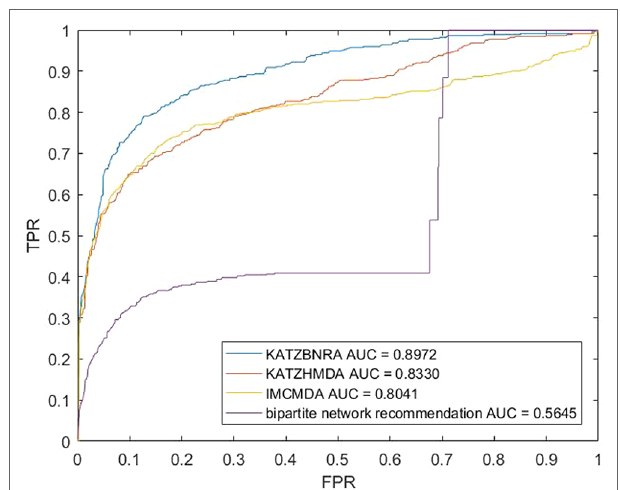
FIGURe 5 | The 5-fold cross validation experimental results of KAZTBNRA, KATZHMDA, IMCMDA, and the native bipartite network recommendation.